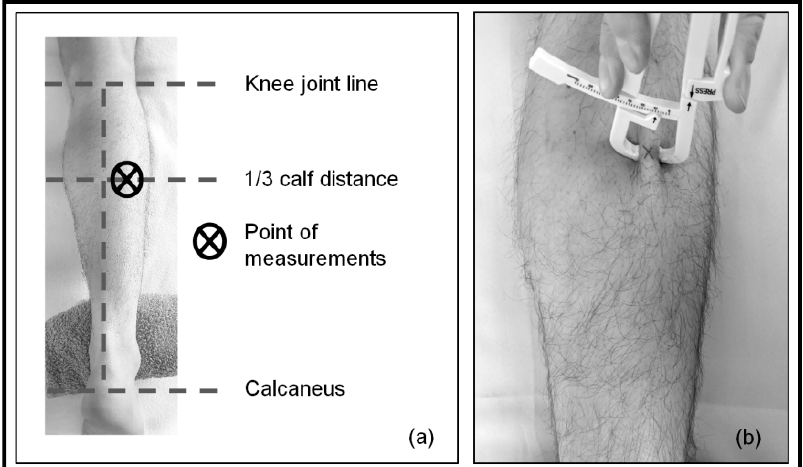
Figure 1. Location of the measurements. ( a ) Determination of the measurement location: cranial 1/3 calf distance, lateral head of gastrocnemius muscle; ( b ) measurement of skinfold thickness with skinfold caliper at the point of measurements.